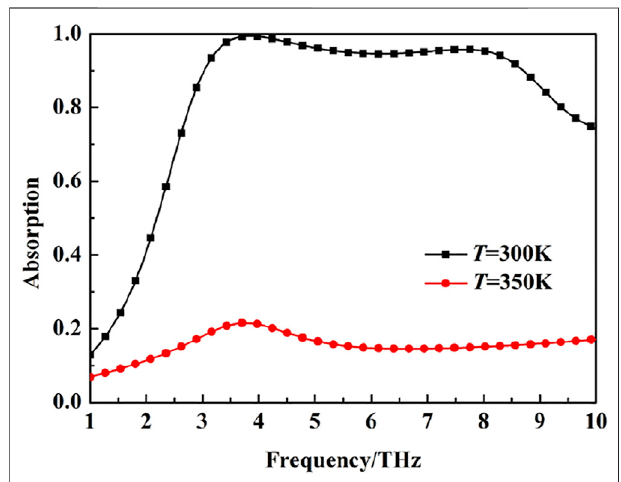
FIGURE 2 | The absorption of the metamaterial absorber under the temperatures T (cid:1) 300 K and T (cid:1) 350